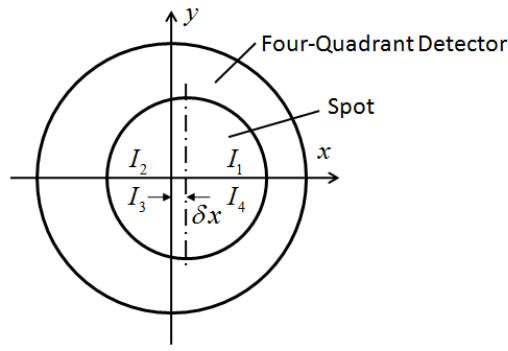
Figure 5. Structure of the four-quadrant detector.